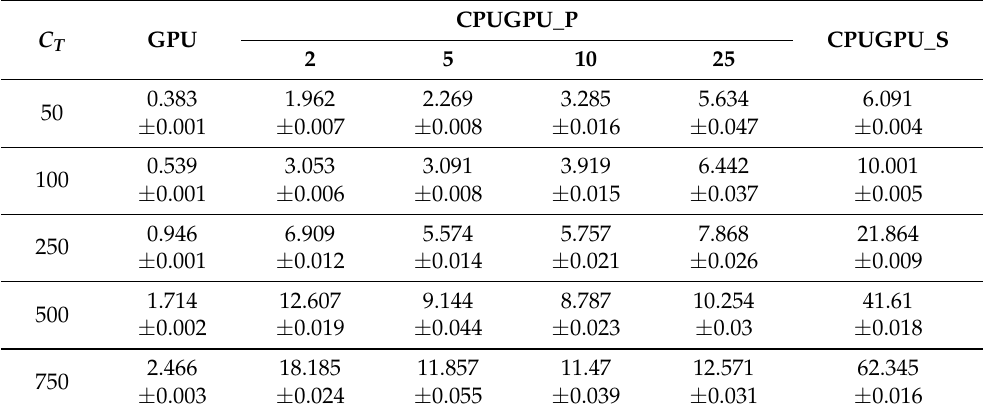
Table 5. Effect of number of observations on computation time. Results of experiments for random action with DNN model ( C S = 50).